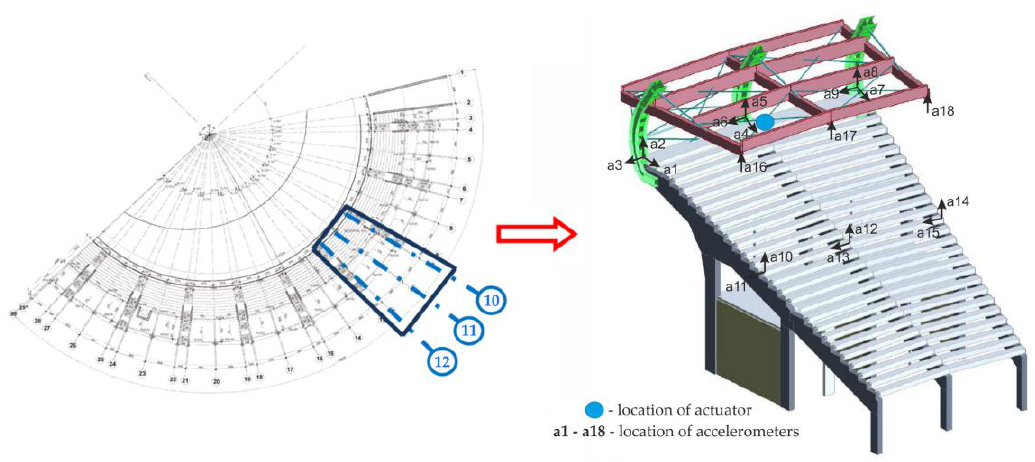
Figure 4. The stand section selected for field tests.